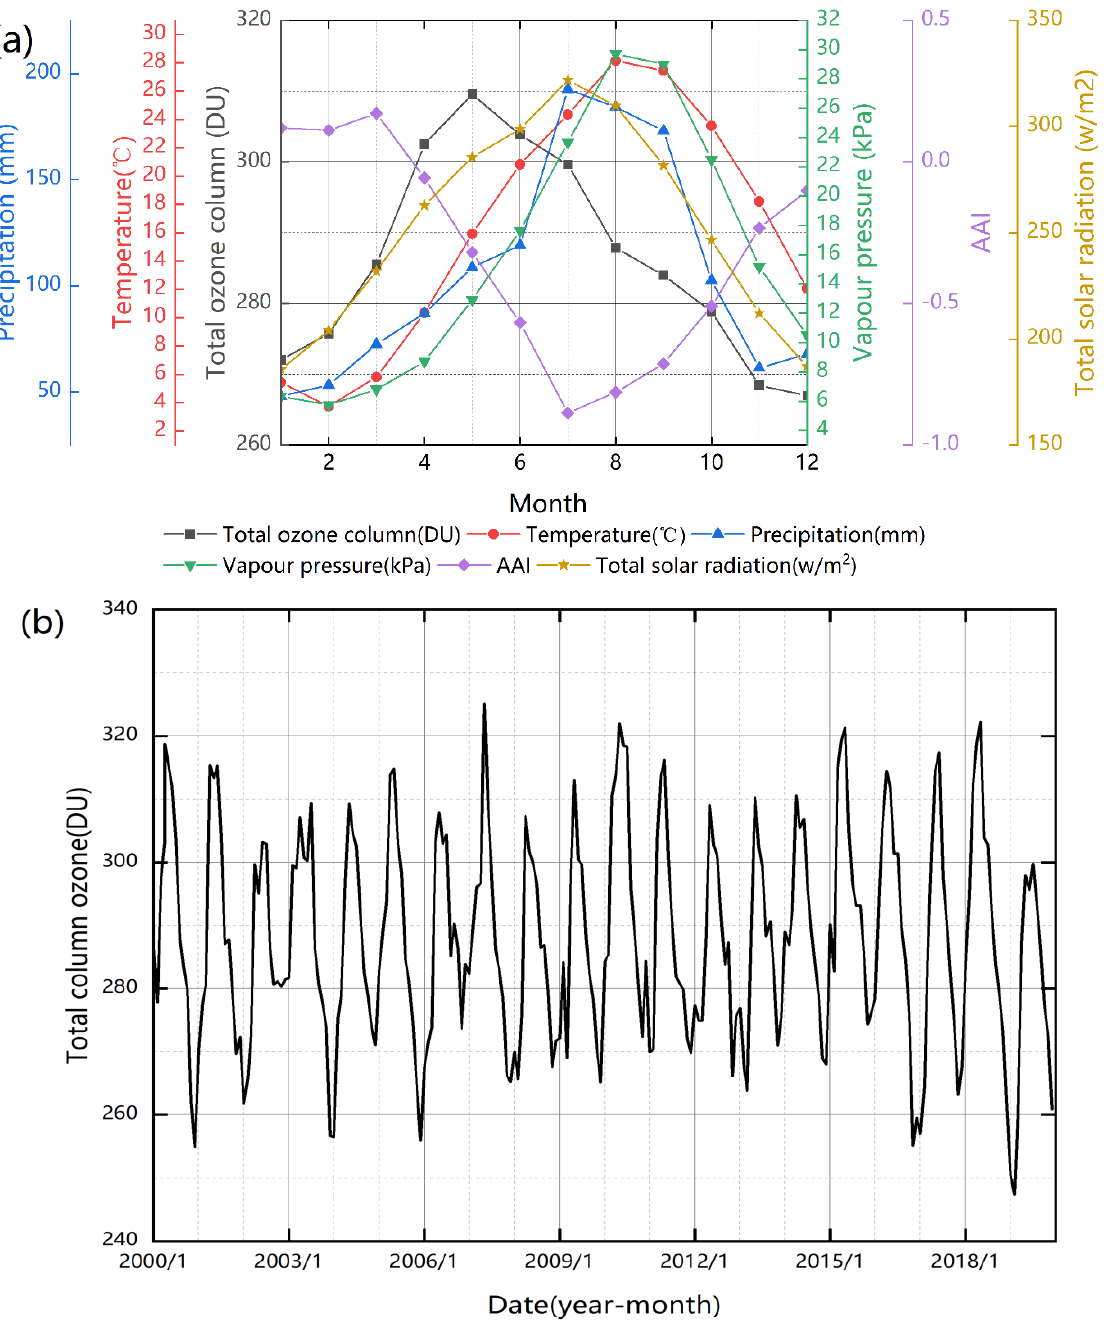
Figure 5. ( a ) The monthly variation curves of the TCO and meteorological factors over the Yangtze River Delta Urban Agglomerations within a year; ( b ) the monthly change in the TCO of the Yangtze River Delta Urban Agglomerations during 2000–2019. Note: The TCO and meteorological factors in Figure 5a are the mean values of the same months for all years. Figure 5b shows the monthly variation of the TCO for 20